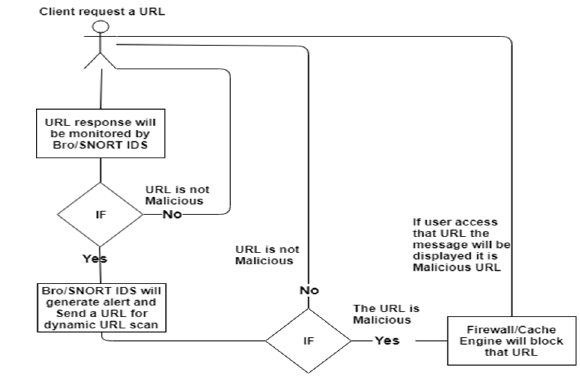
Fig. 2: Malicious Servers Detection